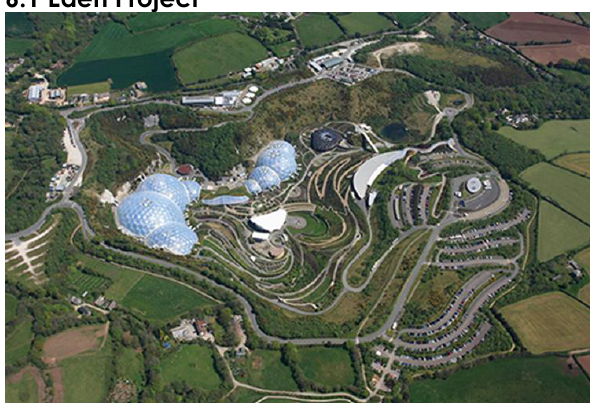
Figure 4. Eden Project [Url 4]